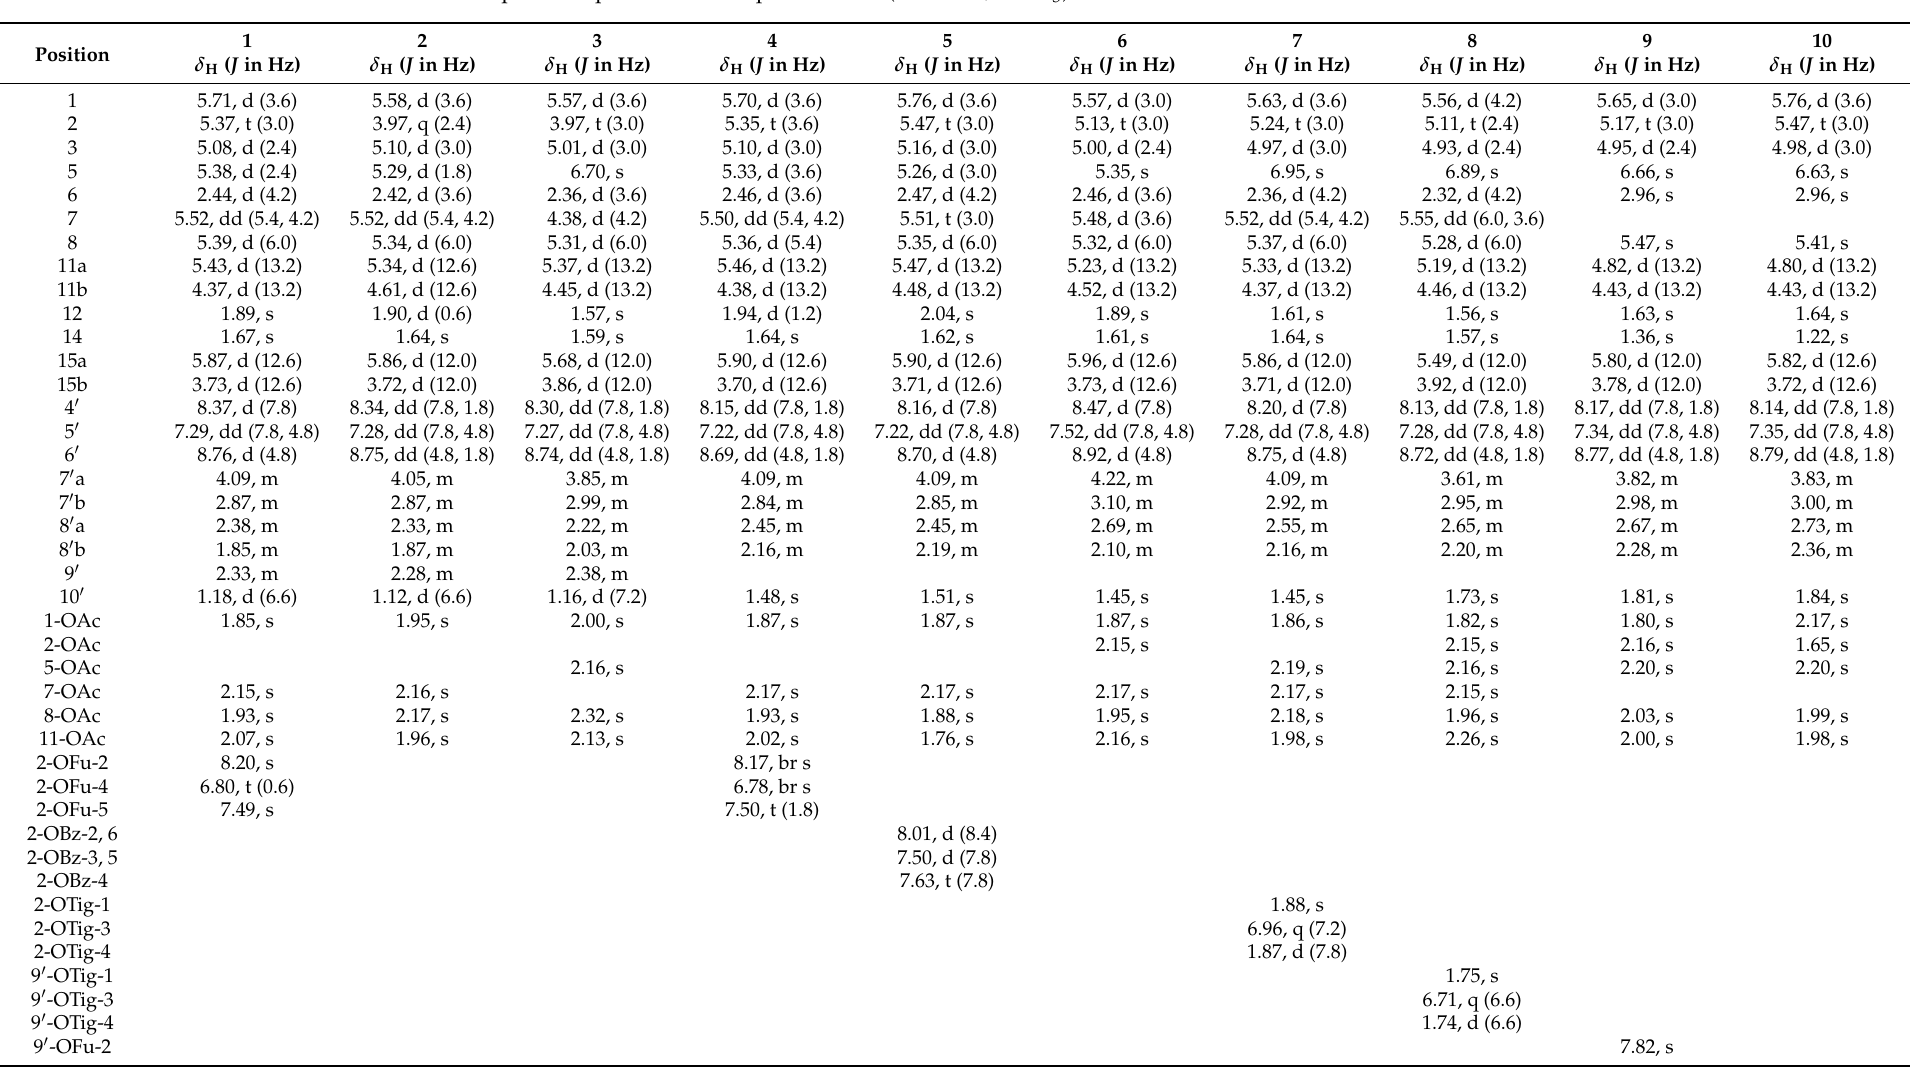
Table 1. 1 H-NMR spectroscopic data for compounds 1 – 10 (600 MHz, CDCl 3